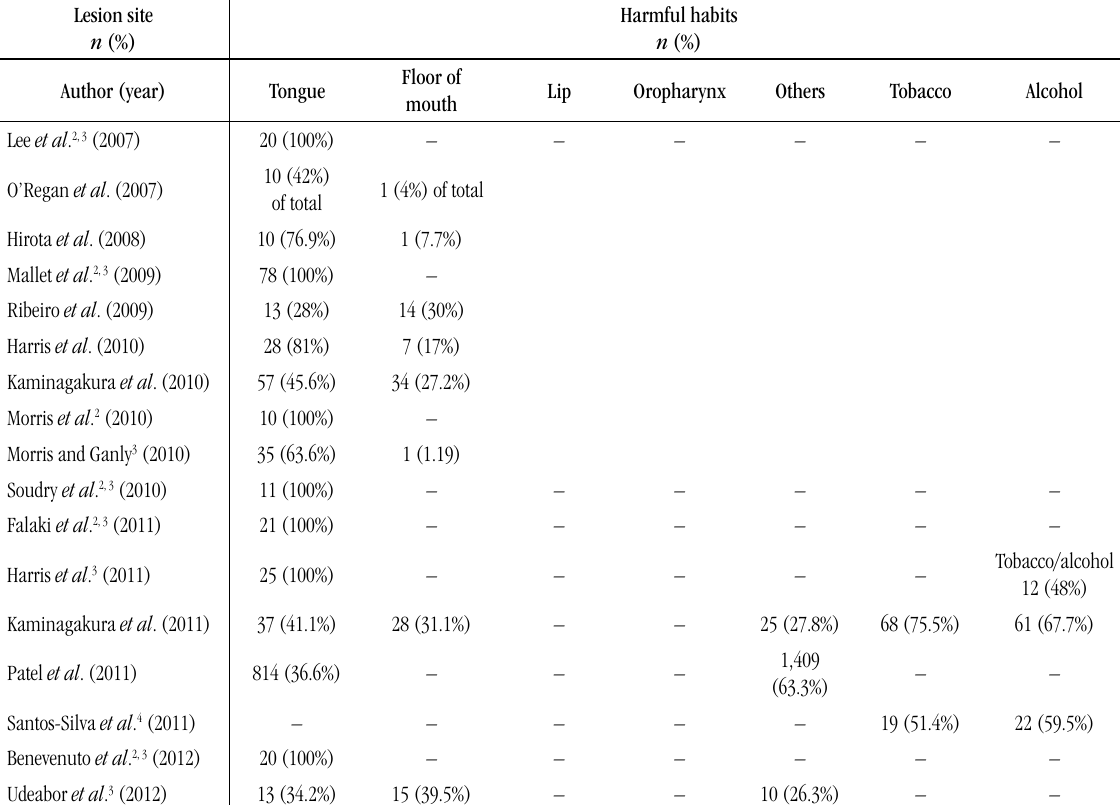
tABLE 2 – Descriptive distribution of the 17 studies on oral squamous cell carcinoma in young patients, selected from PubMed between 2007 and 2012, according to lesion site and association with harmful habits